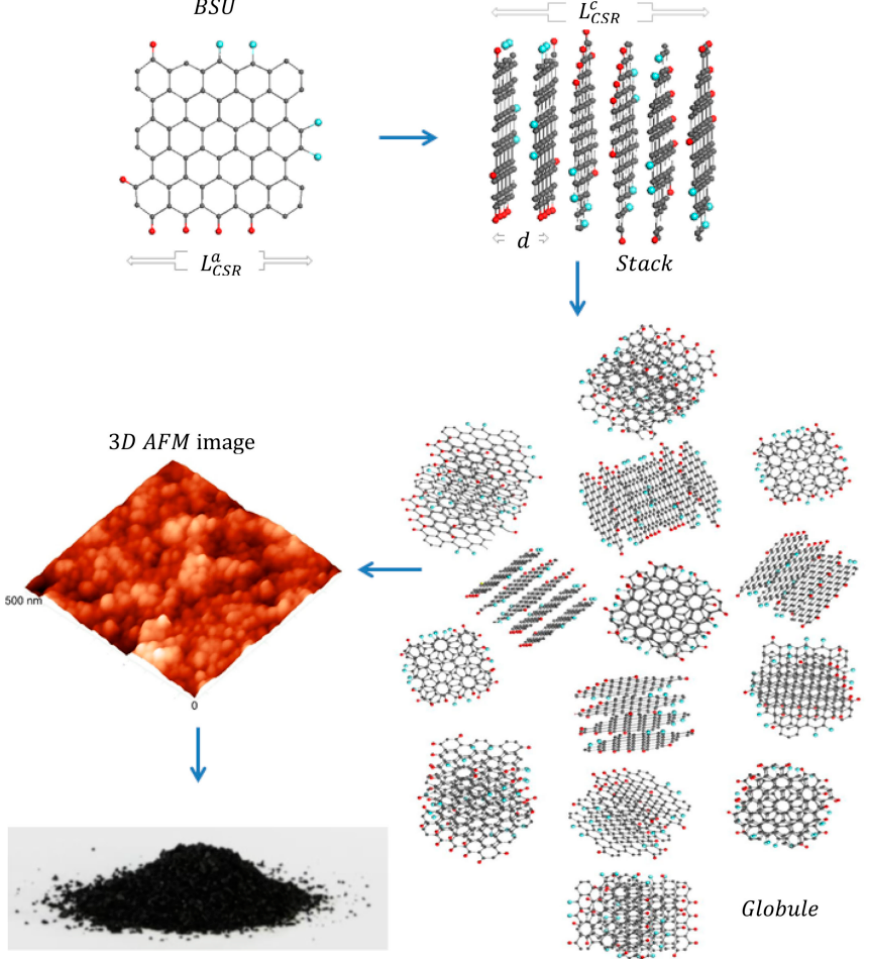
Figure 5. Scheme of the formation of a super-molecular globular structure of natural D sp 2 C (from [52]) through the formation of a stack of graphene layers as basic structural units (BSU) with subsequent aggregation of stacks into a rounded particle (globule). The globules are shown in an atomic force microscope (AFM) image. Along the edges of graphene molecules are heteroatoms (hydrogen (red balls) and oxygen (blue balls)).